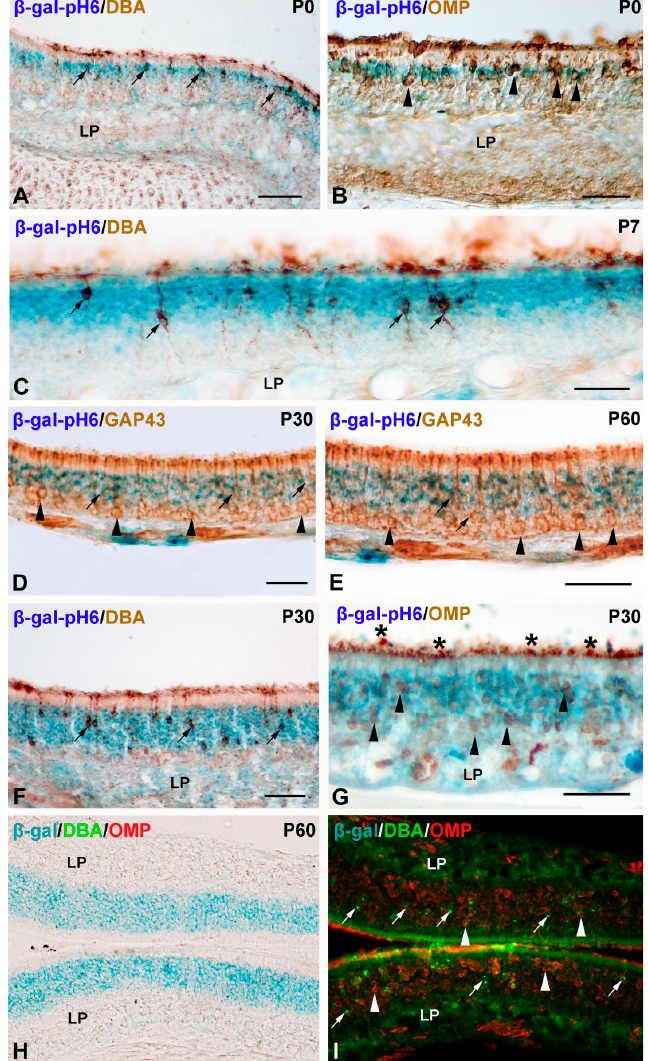
Figure 5. Relationship between β -gal-pH6 histochemical staining and neuronal markers in the developing olfactory mucosa in mice. ( A , B ) In the P0 olfactory epithelium, the cell somata of DBA- positive (arrows) or OMP-immunoreactive (arrowheads) neurons were always located inside the band of β -gal-pH6 staining. ( C ) In the P7 mouse olfactory epithelium, the cell somata of DBA-positive neurons coincided spatially with the β -gal-pH6 signal (arrows). At P30 ( D ) and P60 ( E ) most of the GAP43-immunoreactive neurons were located in the basal surface of the olfactory epithelium in a region negative for the β -gal-pH6 staining (arrowheads). Still, a few of them were found inside this band of labeling (arrows). At P30 ( F , G ) and P60 ( H , I ), the cell somata of DBA-positive (arrows) and OMP-positive (arrowheads) neurons were mainly found inside the band of β -gal-pH6 staining. Intesnse OMP-immunoreaction was detected in the apical surface of the epithelium (asterisks in ( G )). LP, lamina propria; OE, olfactory epithelium. Scale bars: 100 µ